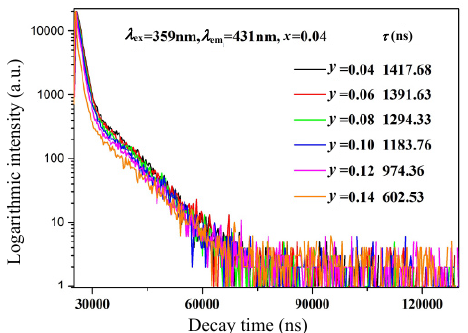
Fig. 10 PL spectra and dependence of η on the amount of Li + in Ba 0.79 Al 10.9 O 17.14 :0.04Eu, y Li + ( y = 0.04–0.14) prepared at 1550 ℃ for 4 h.